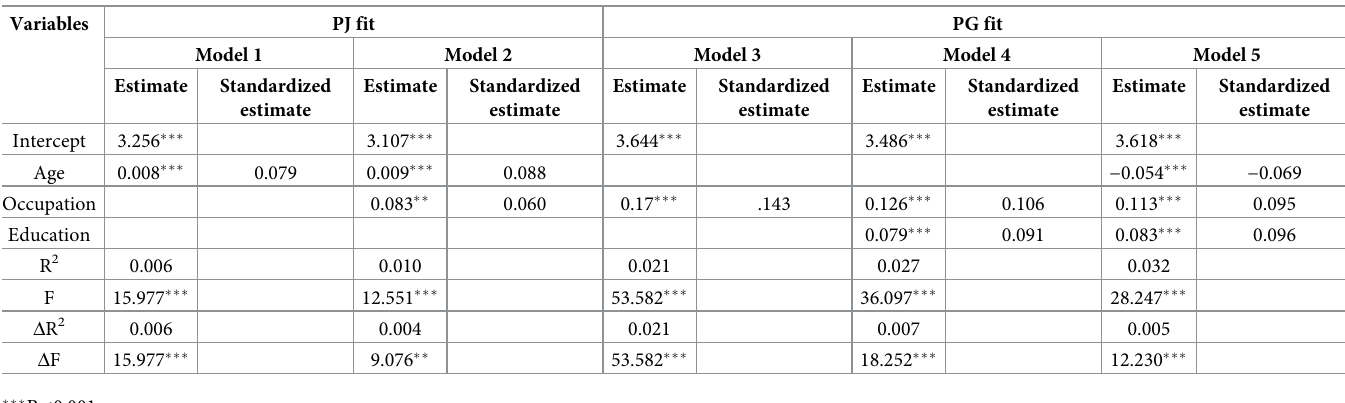
Table 5. Hierarchical regression of PJ and PG